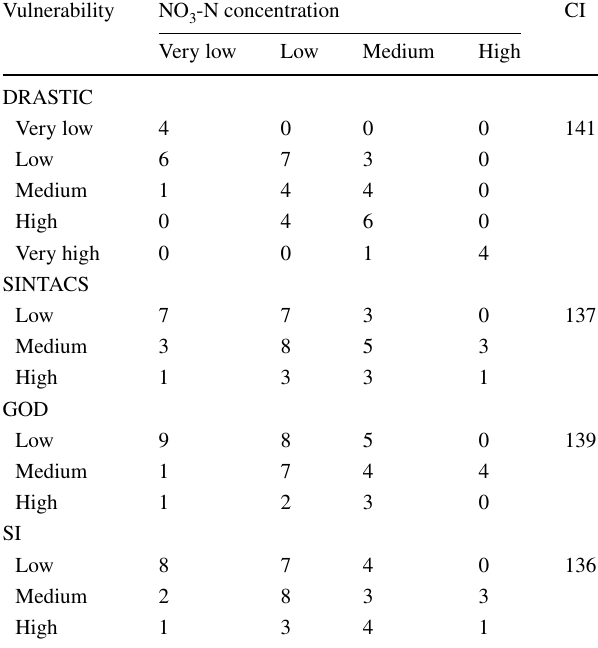
Table 3 Coincidence of wells with three contamination levels and vulnerability categories predicted different models in the validation section (Unit=number of wells)